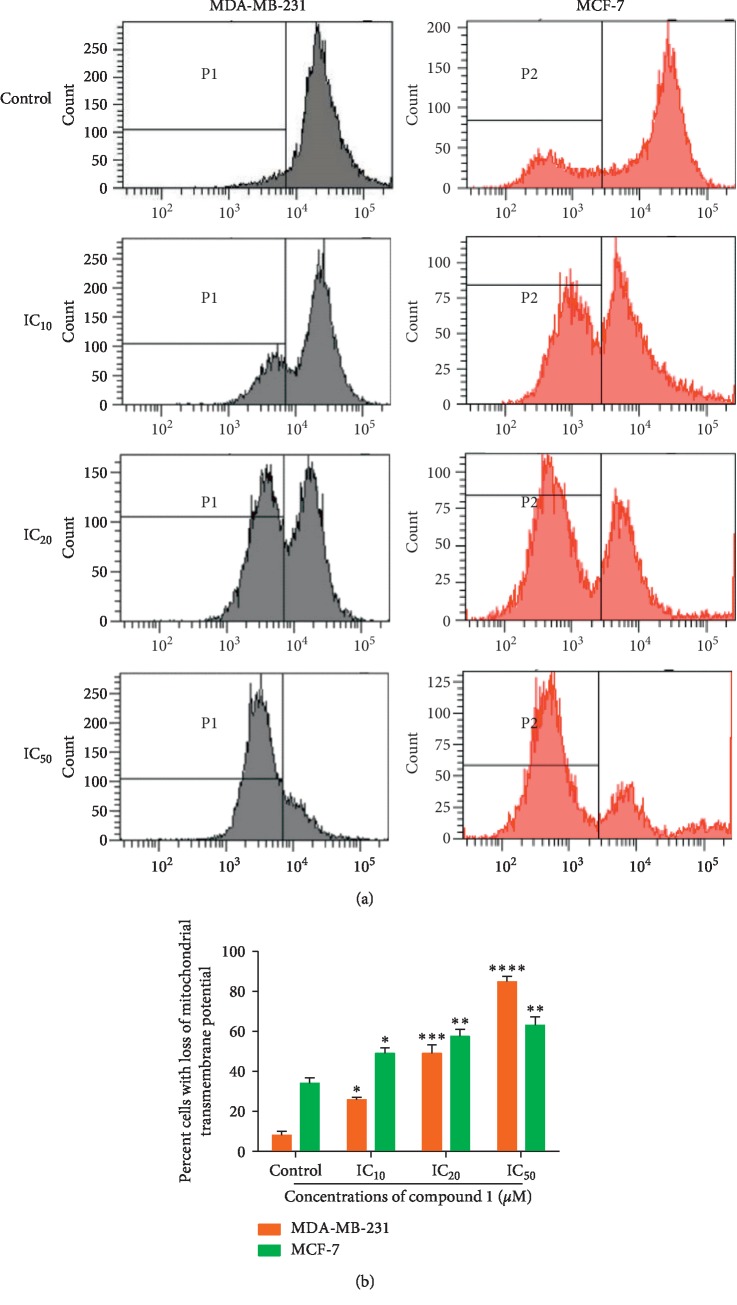
Reduction of mitochondrial transmembrane potential (MTP) of MDA-MB-231 and MCF-7 cells after treatment with compound 1. MDA-MB-231 and MCF-7 cells were treated with compound 1 at various concentrations for 24 hours, and MTP was measured by staining with DiOC6 and employing flow cytometry. The relative fluorescence intensity was measured. Histograms (a) and bar graphs (b) of percentage of both cancer cells with losses of MTP are presented. The statistical significance values compared to the control (without treatment) are marked with asterisks, ∗p < 0.05, ∗∗p < 0.01, ∗∗∗p < 0.001, and ∗∗∗∗p < 0.0001.